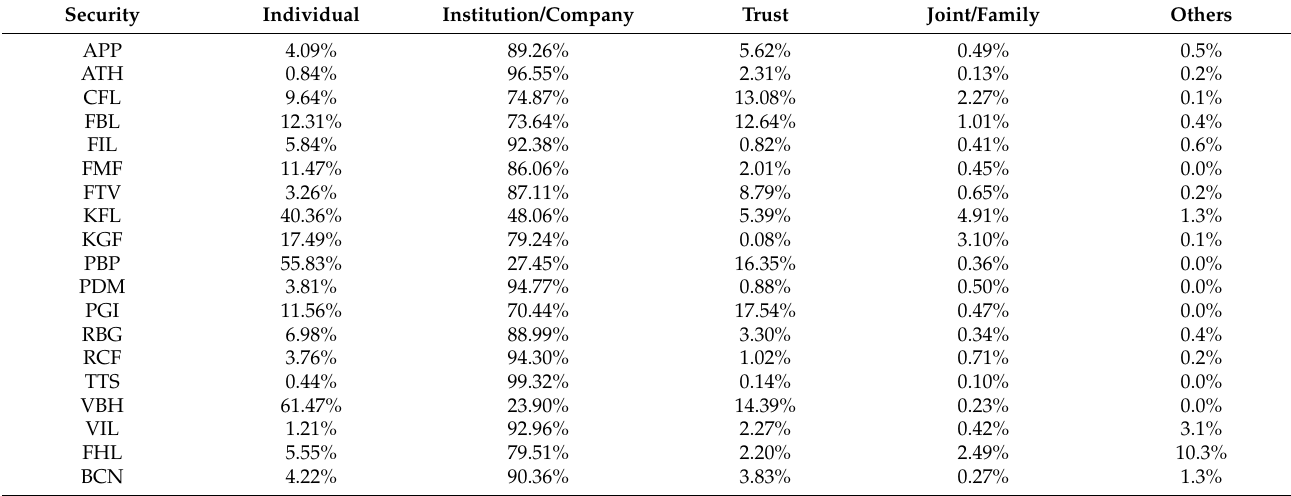
Table 5. Percentage of Security Holding by Investor Type.